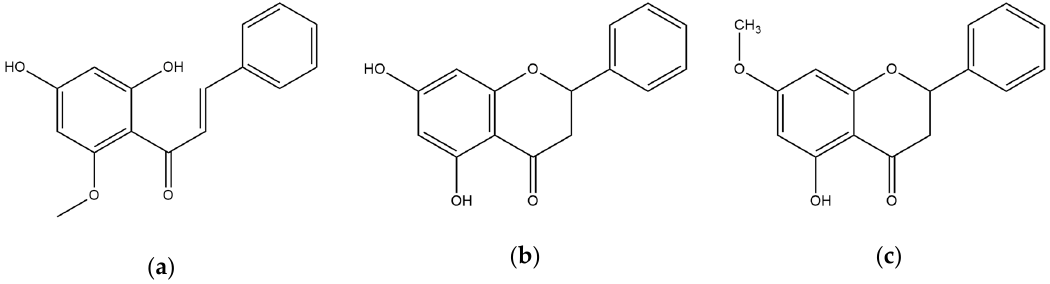
Figure 1. The chemical structures of ( a ) cardamonin, ( b ) pinocembrin, and ( c ) pinostrobin. Table 1. Inhibitory activity and kinetic parameters of cardamonin, pinocembrin, and pinostrobin from B. rotunda against beta-site amyloid precursor protein cleaving enzyme1 (BACE1).